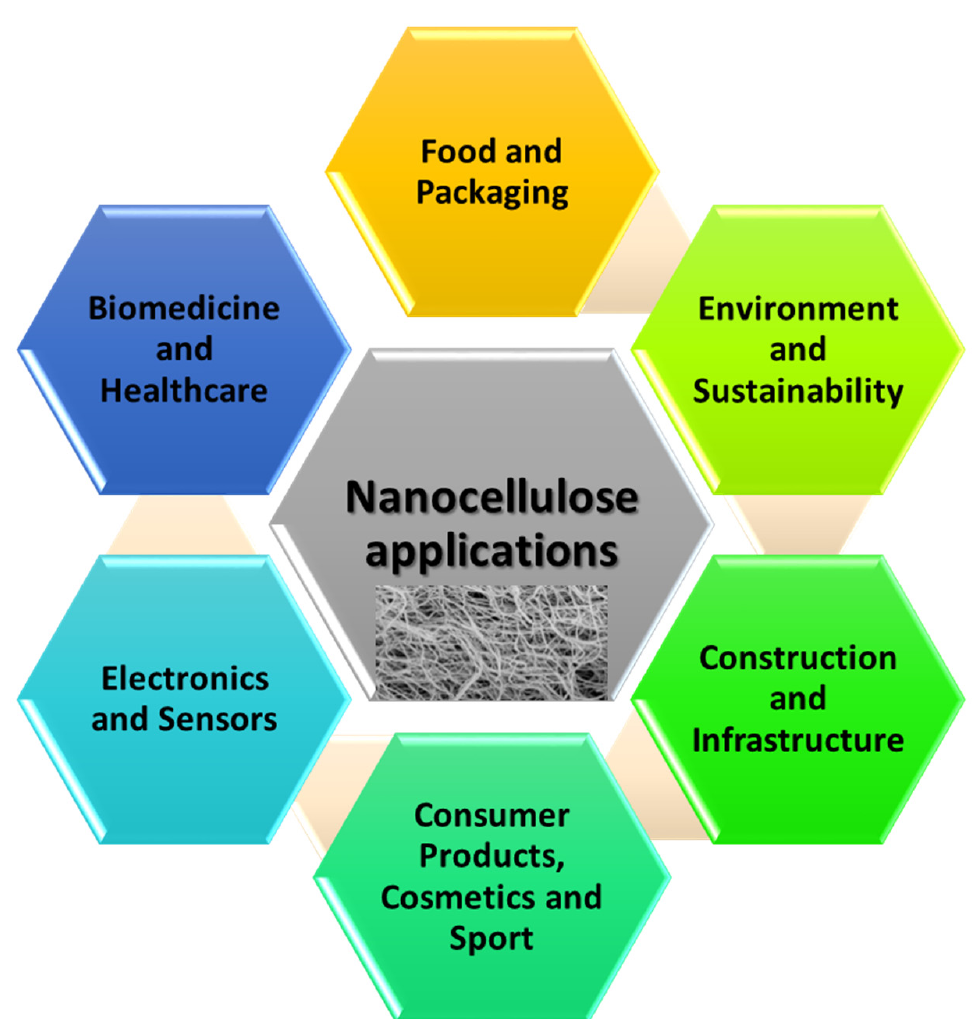
Figure 6. Summary highlighting the broad examples of applications of 3D-printed nanocellulose constructs.